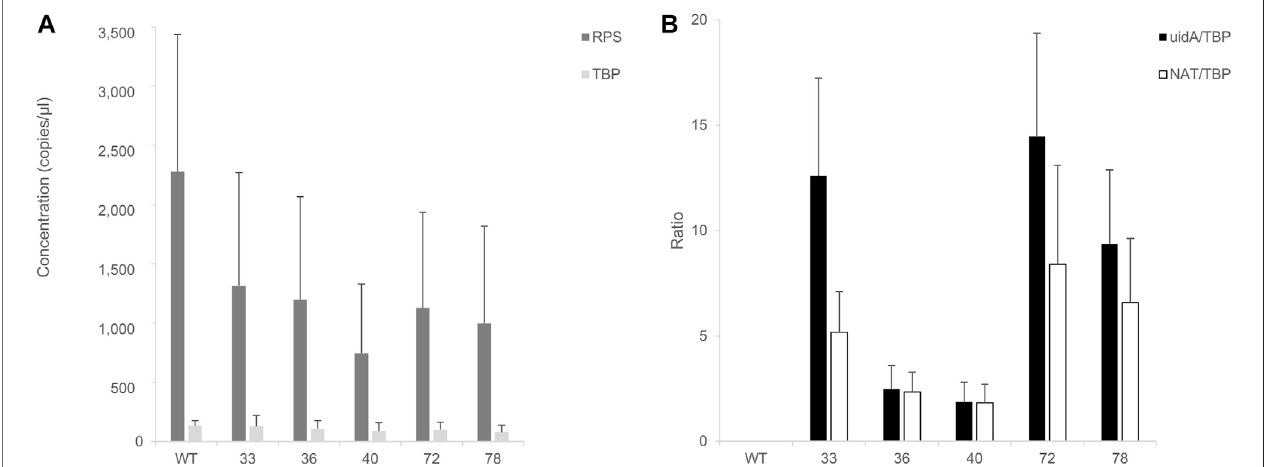
FIGURE6| AssessmentofRT-ddPCRforabsolutemRNAquanti fi cation. (A) Quanti fi cationof RPS and TBP mRNAconcentrations(copies/µl)inclonesharboringa single and intact copy number of transgene (33, 36, 40, 72, 78). Bar chart of cDNA concentrations ( y -axis) detected by ddPCR of TBP (light gray) and RPS (dark gray). Wildtype(WT)isincludedascontrol.Errorbarsin fi gurerepresentstandarddeviation(SD)ofthemeansofthreeindependentexperiments. (B) Quanti fi cationof uidA and NAT mRNA level. Normalized ratios of the cDNA concentration of targeted genes ( uidA : black; NAT : white) on TBP concentrations detected in the clones are from three independent experiments. A wild type (WT) strain is included as a negative control. uidA / TBP ratios calculated for each clones 33, 72, and 78 were individually comparedtoclone 36 uidA / TBP ratioand clone 40 uidA / TBP ratioandwerefoundstatistically different( t -test, p -value < 0.05) ( uidA_33 vs. uidA_40 , p -value (cid:2)